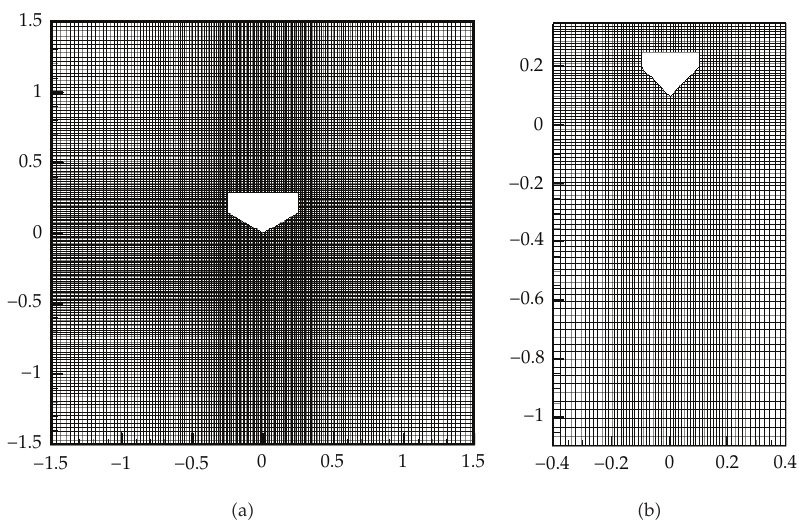
Figure 1: Global mesh of test model 1 (cid:2) a (cid:3) and test model 2 (cid:2) b (cid:3) in fluid